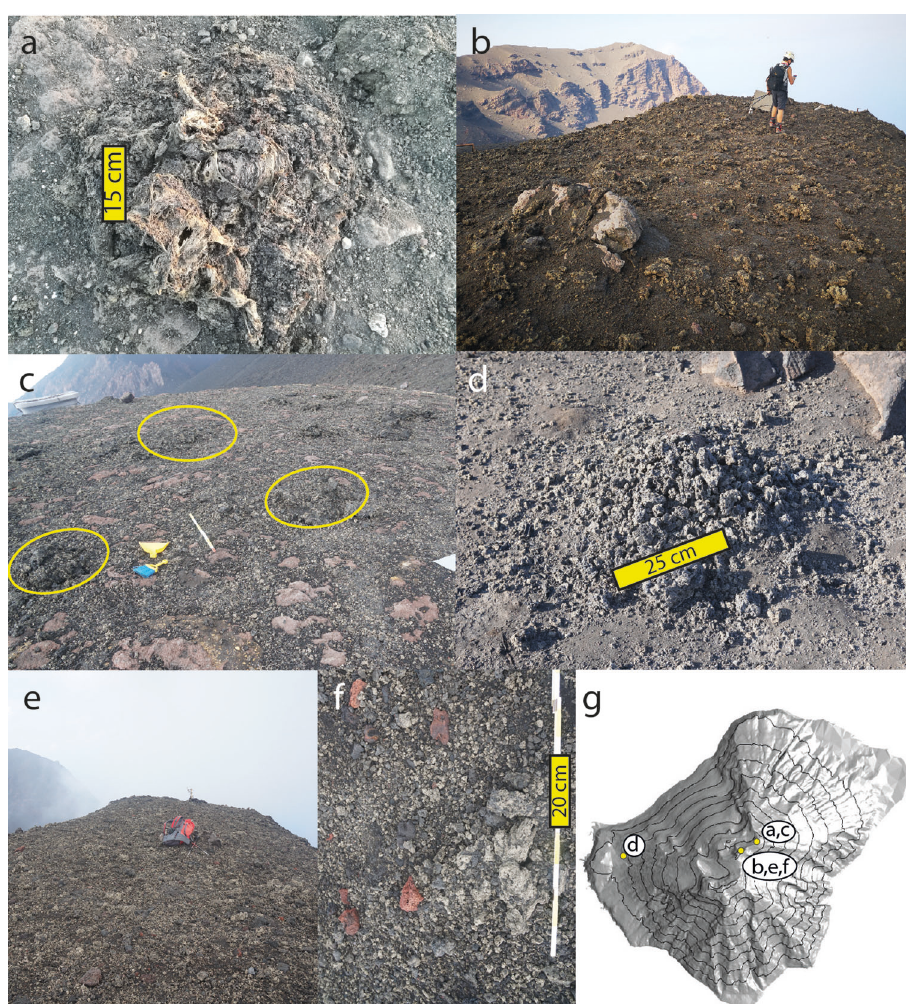
Fig. 3 Impact of ballistics and tephra fallout after the paroxysms. a – d 3 July: ( a ) LP-dominated 0.6 m-sized spatter bomb resting above an HP bomb close to the summit trail, 450 m away from the craters; ( b ) continuous spatter and tephra coverage at Pizzo after 3 July; ( c ) discontinuous spatters coverage close to ( a ); ( d ) decimeter-sized bomb broken upon impact close to Ginostra village. e – f 28 August: ( e ) Continuous tephra fallout coverage at Pizzo after paroxysm; ( f ) detail of the deposit at Pizzo, showing unsorted fallout deposit, mainly made of pumices and non-juvenile fragments (reddish blocks and subvolcanic material); ( g ) map indicating the location of fi eld observations. Photos by F. Ciancitto ( a ) and D. Andronico ( b – f